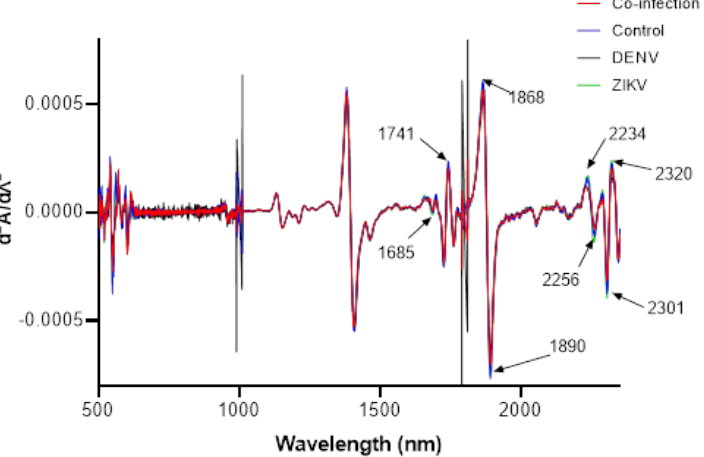
Figure 5. The second derivative spectra of Aedes aegypti mosquitoes showing overtones of infected and uninfected groups. The black arrows in the figure indicate the wavelength (nm) band regions that are important for differentiating the groups.